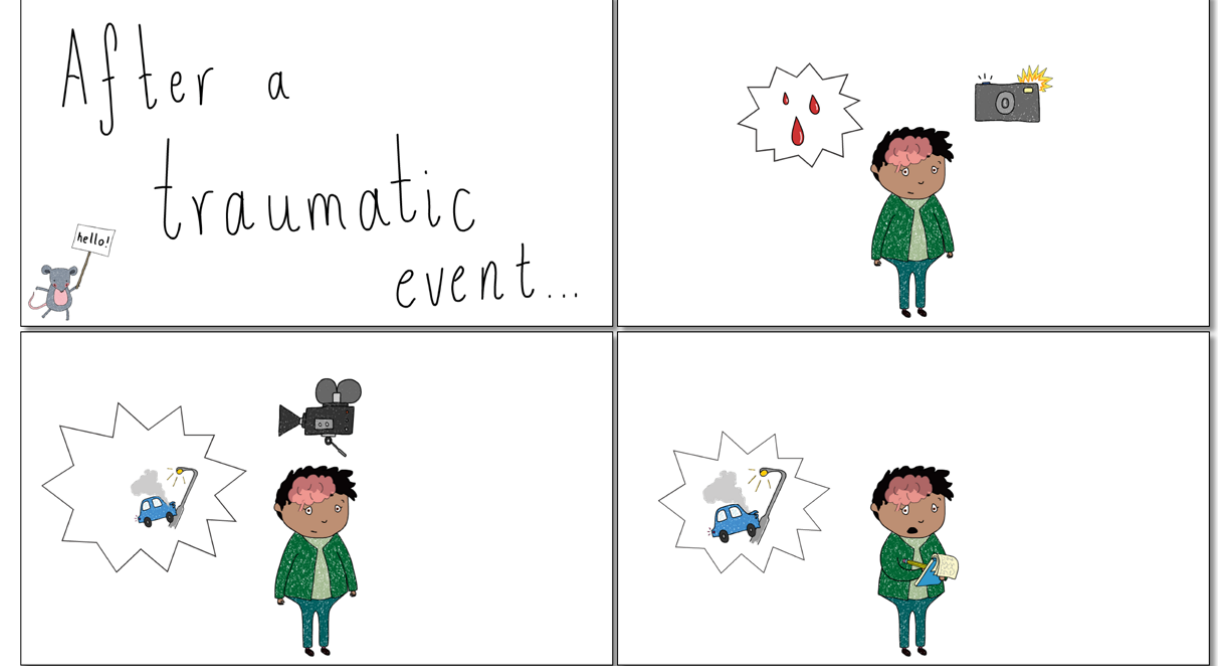
Figure 1. Screenshots from the “What are Intrusive Memories?” video, which explains the target symptom of the intervention in an accessible way.